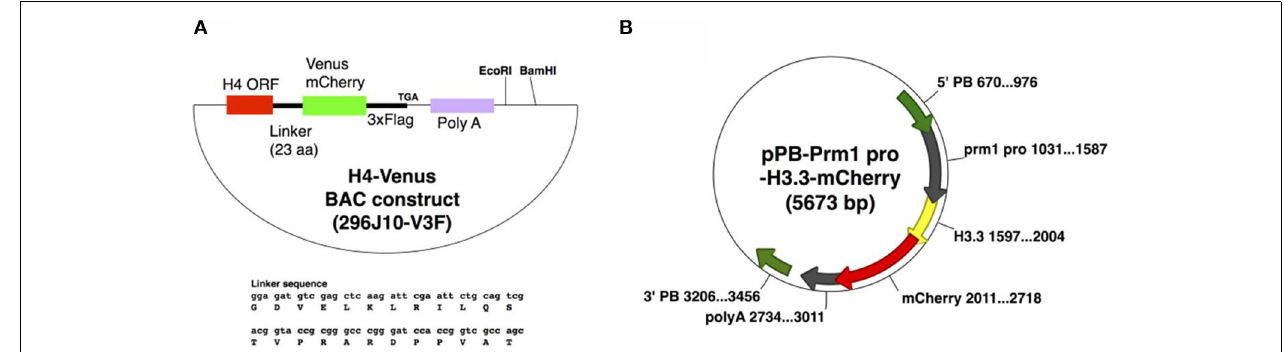
FIGURE 1 | Plasmid maps to generate H4V (A) and H33C (B) Tg mice.